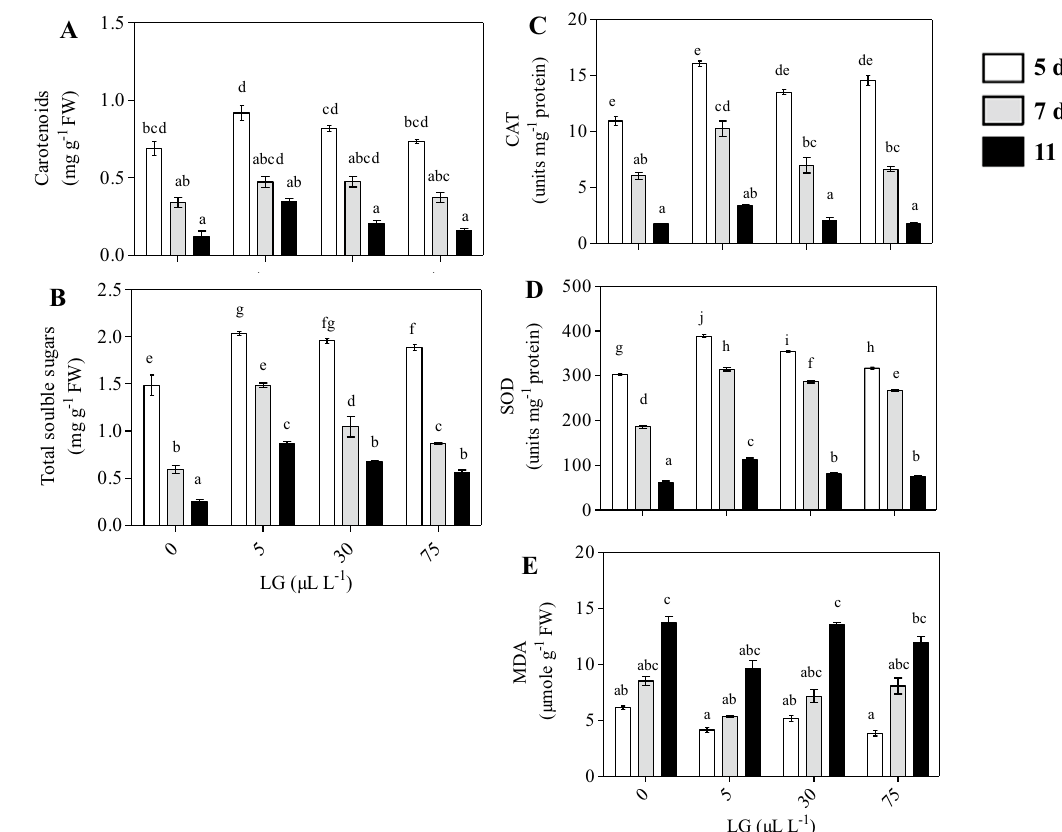
Figure 5. Total soluble sugar content ( A ), Carotenoid content ( B ), MDA ( C ), SOD activity ( D ), CAT activity ( E ), in the petals of untreated (distilled water) and LG essential oil treated gladiolus spikes. The Gladiolus spikes were treated with different LG essential oil concentration (0, 5, 30 and 75 µL L −1 ). Each value is the mean ± SE of three replicates. Means with different letters are significantly different at 5% probability (Tukey’s Test). *Petals from the fourth floret was used for the